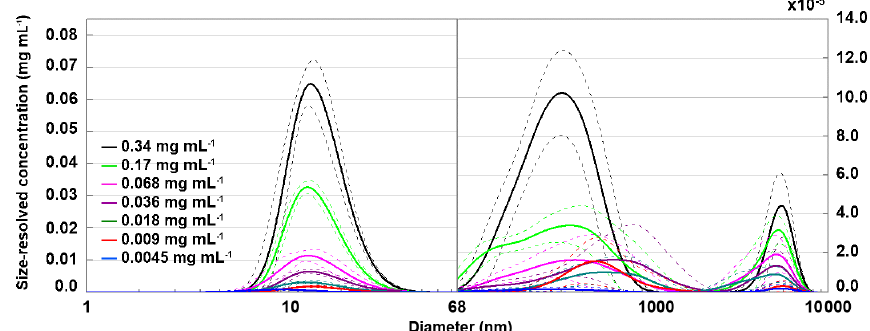
Figure 7. Hydrodynamic diameter of apoferritin (batch 2) depending on solution concentration measured with DLS with concentrations listed in the legend. Size-resolved concentrations are obtained by multiplying the volume-weighted distribution with the apoferritin concentration. The main peak at 12 . 5 ± 0 . 3nm corresponds to cage monomers and cage oligomers. The weak peaks above 68nm (note the different y -axis scale) arise from cage aggregates. Solid lines are averages of multiple measurements, and dashed lines indicate 1 standard